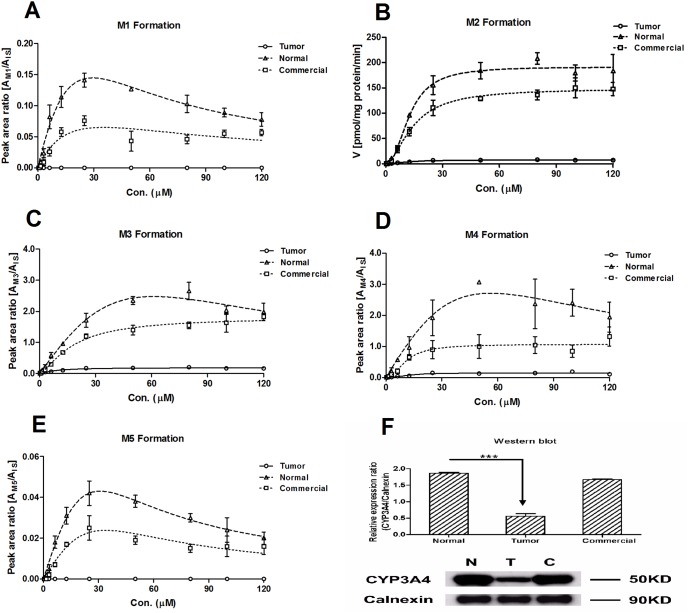
Sorafenib metabolism by CYP3A4 (A–E) and CYP3A4 protein expression (F) in pooled NHLMs, THLMs and CHLMs.The formation rate of M2 expressed as pmol/mg/min (mean ± SD), other metabolites rates (M1, M3, M4 and M5) expressed as peak area ratio (mean ± SD). All the experiments were carried out in triplicate. One-way ANOVA, with or without Tukey–Kramer multiple comparison (post-hoc) tests, was used for data analysis. “*” denotes statistical significance (P<0.05); “**” denotes statistical significance (P<0.01), “***” denotes statistical significance (P<0.001).